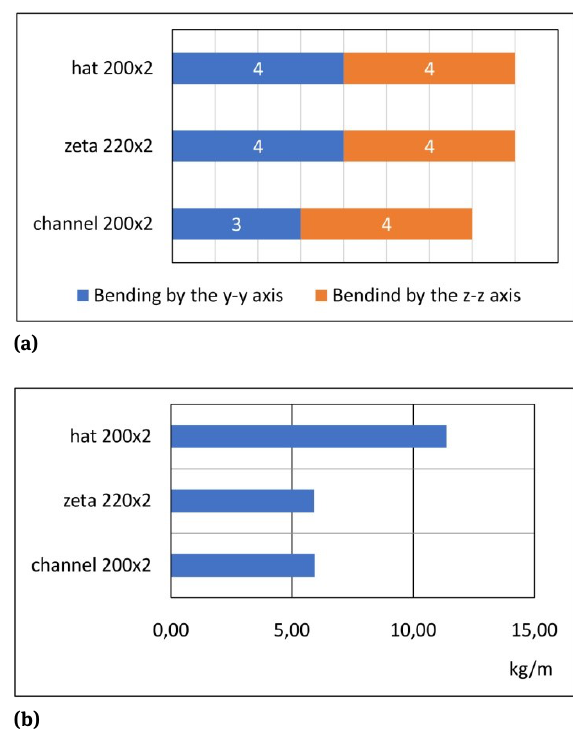
Figure 5: a) Class of cross-section, b) Self-weight of profiles